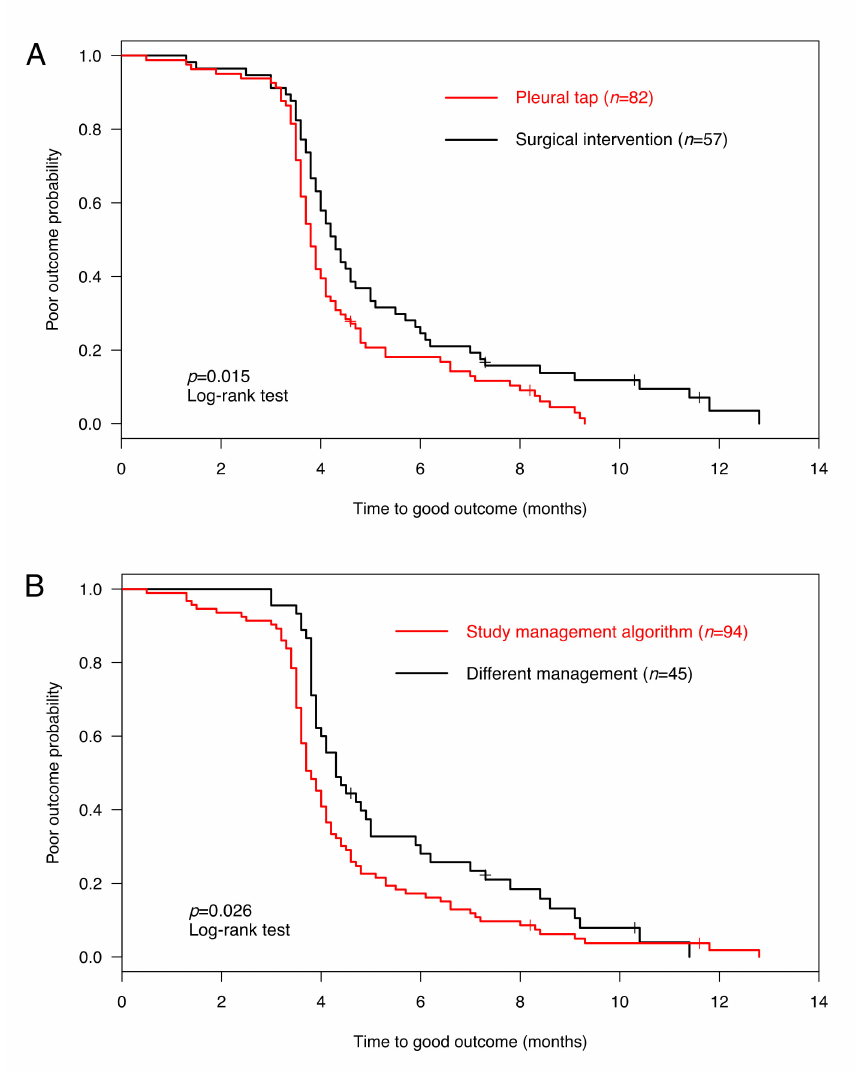
Figure 2. Outcome analysis of 139 children with parapneumonic e ff usion or pleural empyema (PPE / PE). ( A ) Time to good outcome of PPE / PE with pleural tap alone (red) or surgical intervention (black) (i.e., pleural draining catheter ± fibrinolysis, video-assisted thoracoscopic surgery, or thoracotomy). ( B ) Time to good outcome of PPE / PE managed according to the study management algorithm (red) or with di ff erent management (black). Poor outcome was defined as no clinical recovery and / or abnormal chest radiograph according to the British Thoracic Society (BTS) guidelines [1]. The log-rank test was used to compare the time to